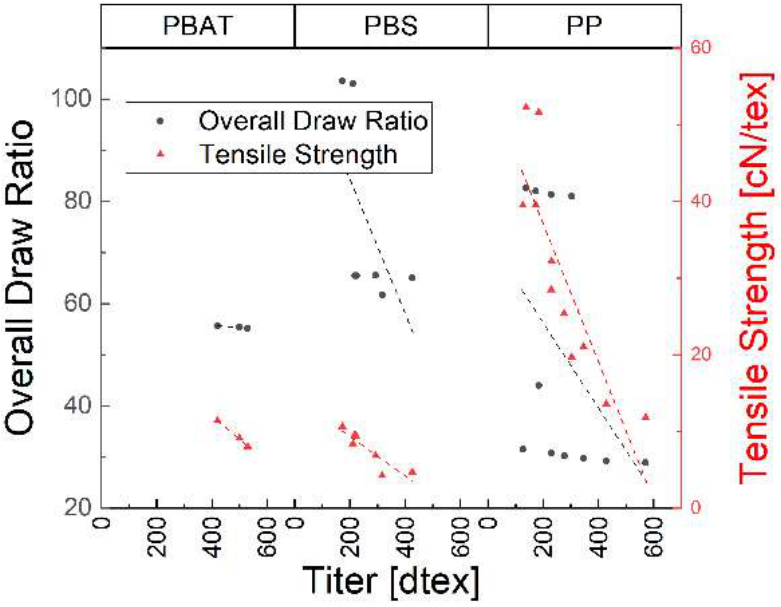
Figure 15. Overall draw ratio and tensile strength over fiber fineness for three polymers. At higher ODRs, the crystallinity of all three polymers increased as the titer decreased (Figure 16). Furthermore, we expected and confirmed that the tensile strength increased with higher values of M w and the tenacity increased with higher values of crystallinity, which was directly linked to a higher drawing ratio in the fiber spinning process. The ratio between disorganized and oriented polymers is between two and five [27]. Crystallinity and Mw of PBS are higher than PBAT, but the tenacity is similar. This indicates that